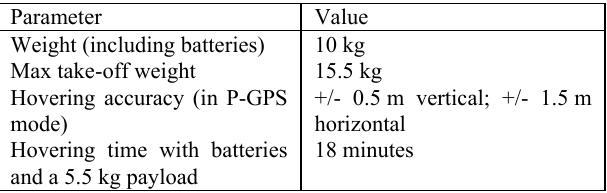
Table 2. Matrice 600 Pro Specifications (DJI, 2019)